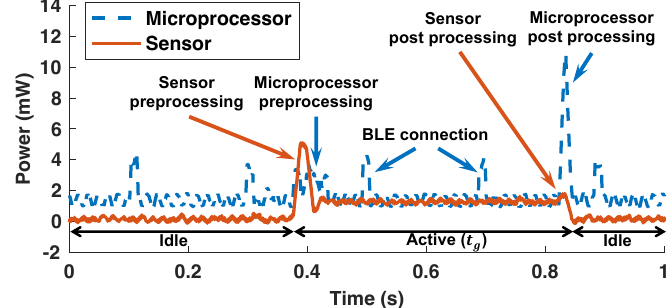
Figure 5. Power consumption during a gesture recognition when t g = 400